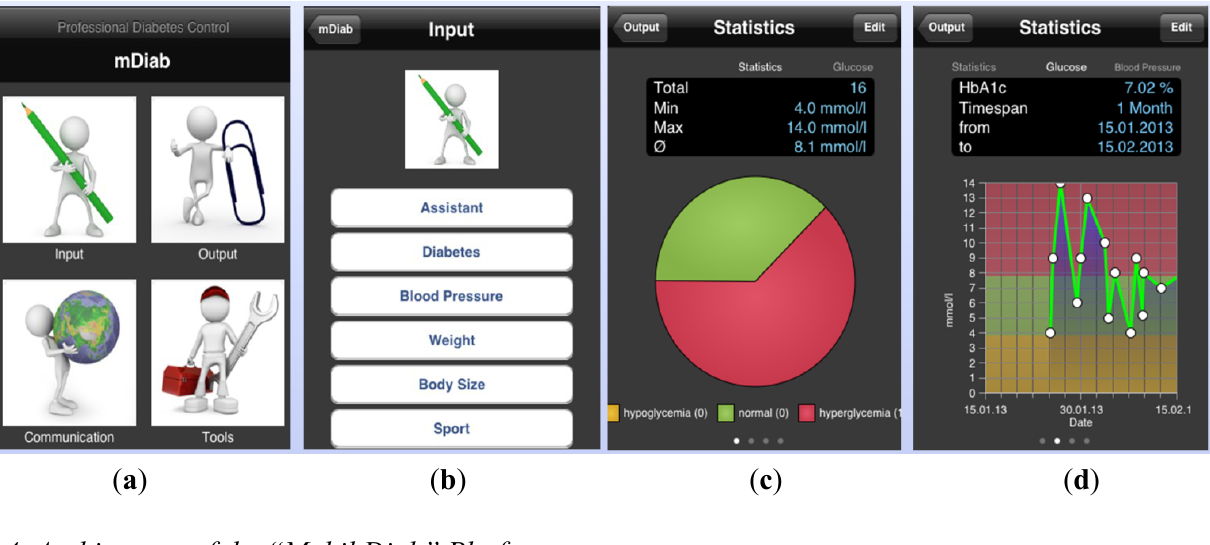
Figure 2. Mobil Diab Mobile Application: ( a ) Screenshots of the main screen; ( b ) input choices; ( c , d ) blood glucose